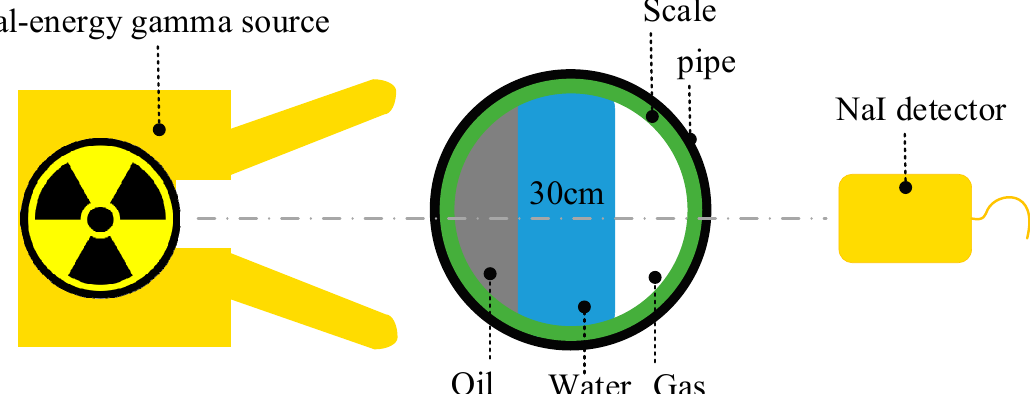
Figure 1. The structure of the simulated detection system.